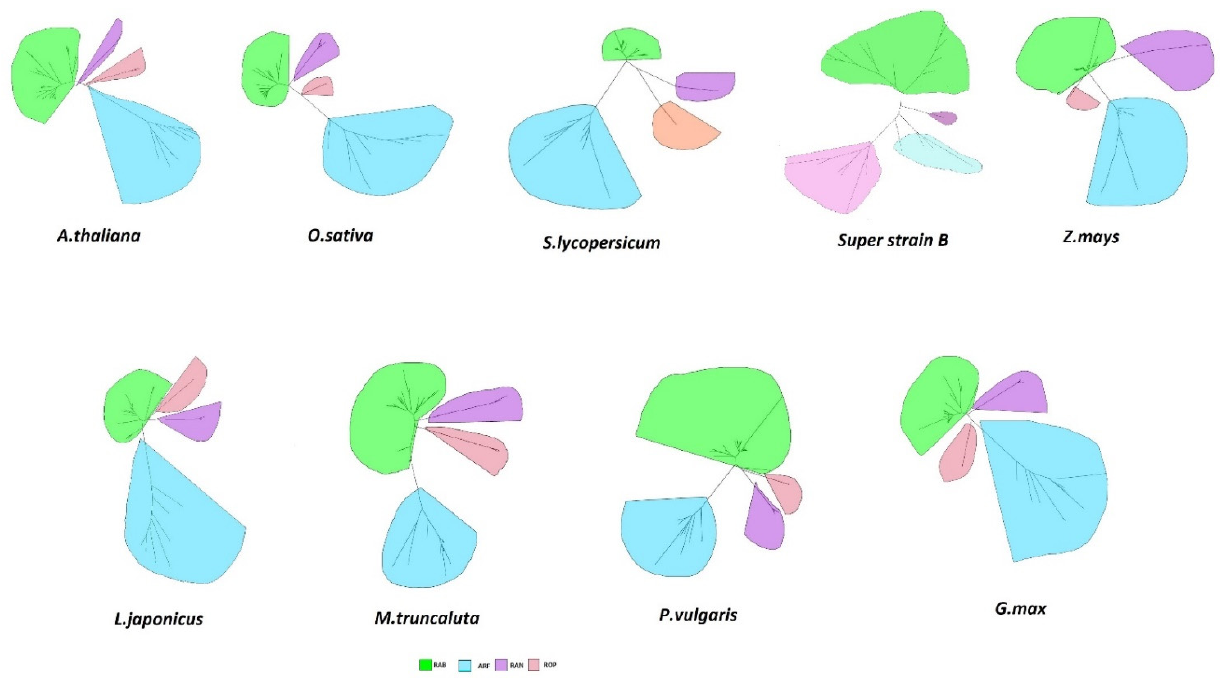
G. max a 50 0 Note: a compared to leaf; b compared to shoot (2-week-old); c compared to stem; d compared to leaf (6-week-old). Monomeric GTPase sequences of amino acids from tBLASTn searches were applied to recognize the individuals of the small GTPases superfamily of S. lycopersicum super strain B and those retrieved from the genomic databases ( O. sativa , A. thaliana , S. lycopersicum , L. japonicus , Z. mays , M. truncatula , G. max , and P. vulgaris ). Amino acid sequences of those proteins were employed to create phylogenetic trees of those species, permitting their categorization using small GTPases subfamilies into Rab (green), Arf (blue), Rop (Pink), and Ran (violet), (Figure 1). The phylogenetic inspection of the small GTPase superfamily of the studied leguminous and non-leguminous plants did not reveal asymmetric evolution of the Ra, Arf, Rop, and Ran subfamilies. These results were in accordance with those of Flores et al. [27].